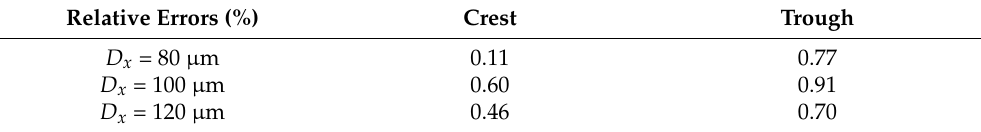
Table 2. Relative errors of regressed hardness.